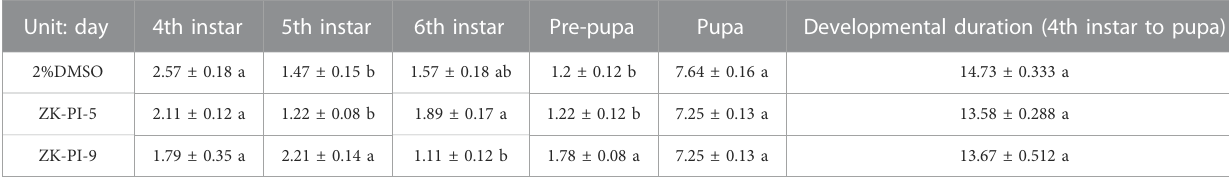
TABLE 4 Developmental duration of S. frugiperda . Unit: day